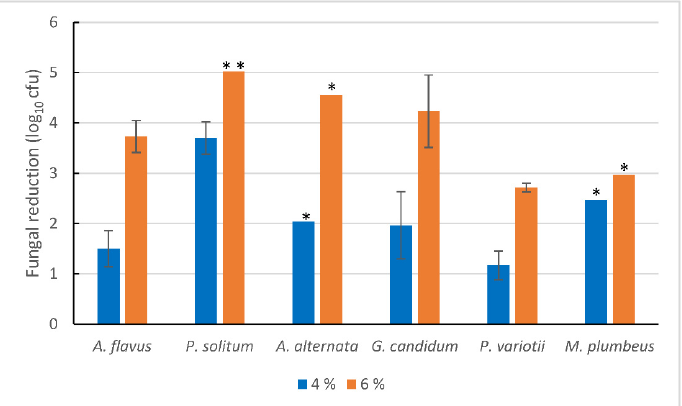
Figure 1. Reduction in log cfu after exposure to 4% or 6% liquid H 2 O 2 in a fungicidal suspension test (15 min at room temperature) for fresh spore suspensions. Mean values and standard error of the mean of three to four experiments shown. Asterisks indicate number of replicates with mould counts below the detection limit (reductions above the detection limit). Standard error not shown for strains with number of surviving cells below detection limit in one or more of the replicates.